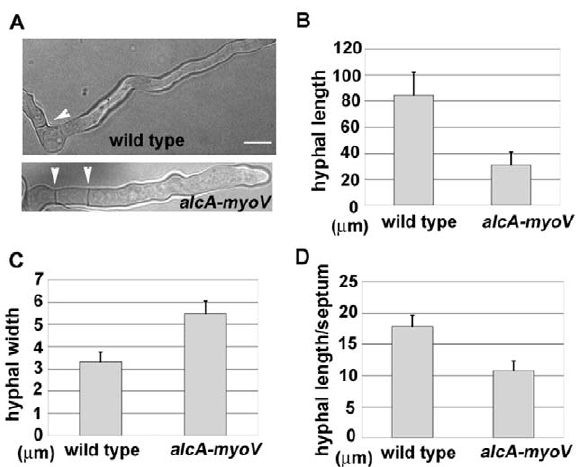
Figure 3. The growth phenotype of the alcA-myoV mutant. (A) Morphology of the alcA-myoV mutant 8 hours after germinating on repressive YUU medium at 37 u C. A wild type cell is shown for comparison. Septa are indicated by arrow heads. (B, C and D) Quantitative analyses of hyphal length (B), hyphal width (C), and septum distribution (D) in wild type and the alcA-myoV mutant. Means and standard deviations are shown in the graphs. For hyphal length measurements, only those hyphae whose entire length could be seen through whole z-stacks (10–20 m m) were measured (n=75 for the mutant; n=70 for the wild type control). For hyphal width measure- ments, values were taken from hyphal regions where the hyphal width is uniform (n=37 for both the mutant and the wild type control). For measurements of septum distribution, the lengths of the hyphal segments between adjacent septa were measured (n=172 for the mutant; n=147 for the wild type control). The differences between the mutant and the wild type controls are significant for hyphal length, hyphal width, and the length of hyphal segments (p , 0.01 in all three cases). Bar, 5 m m.